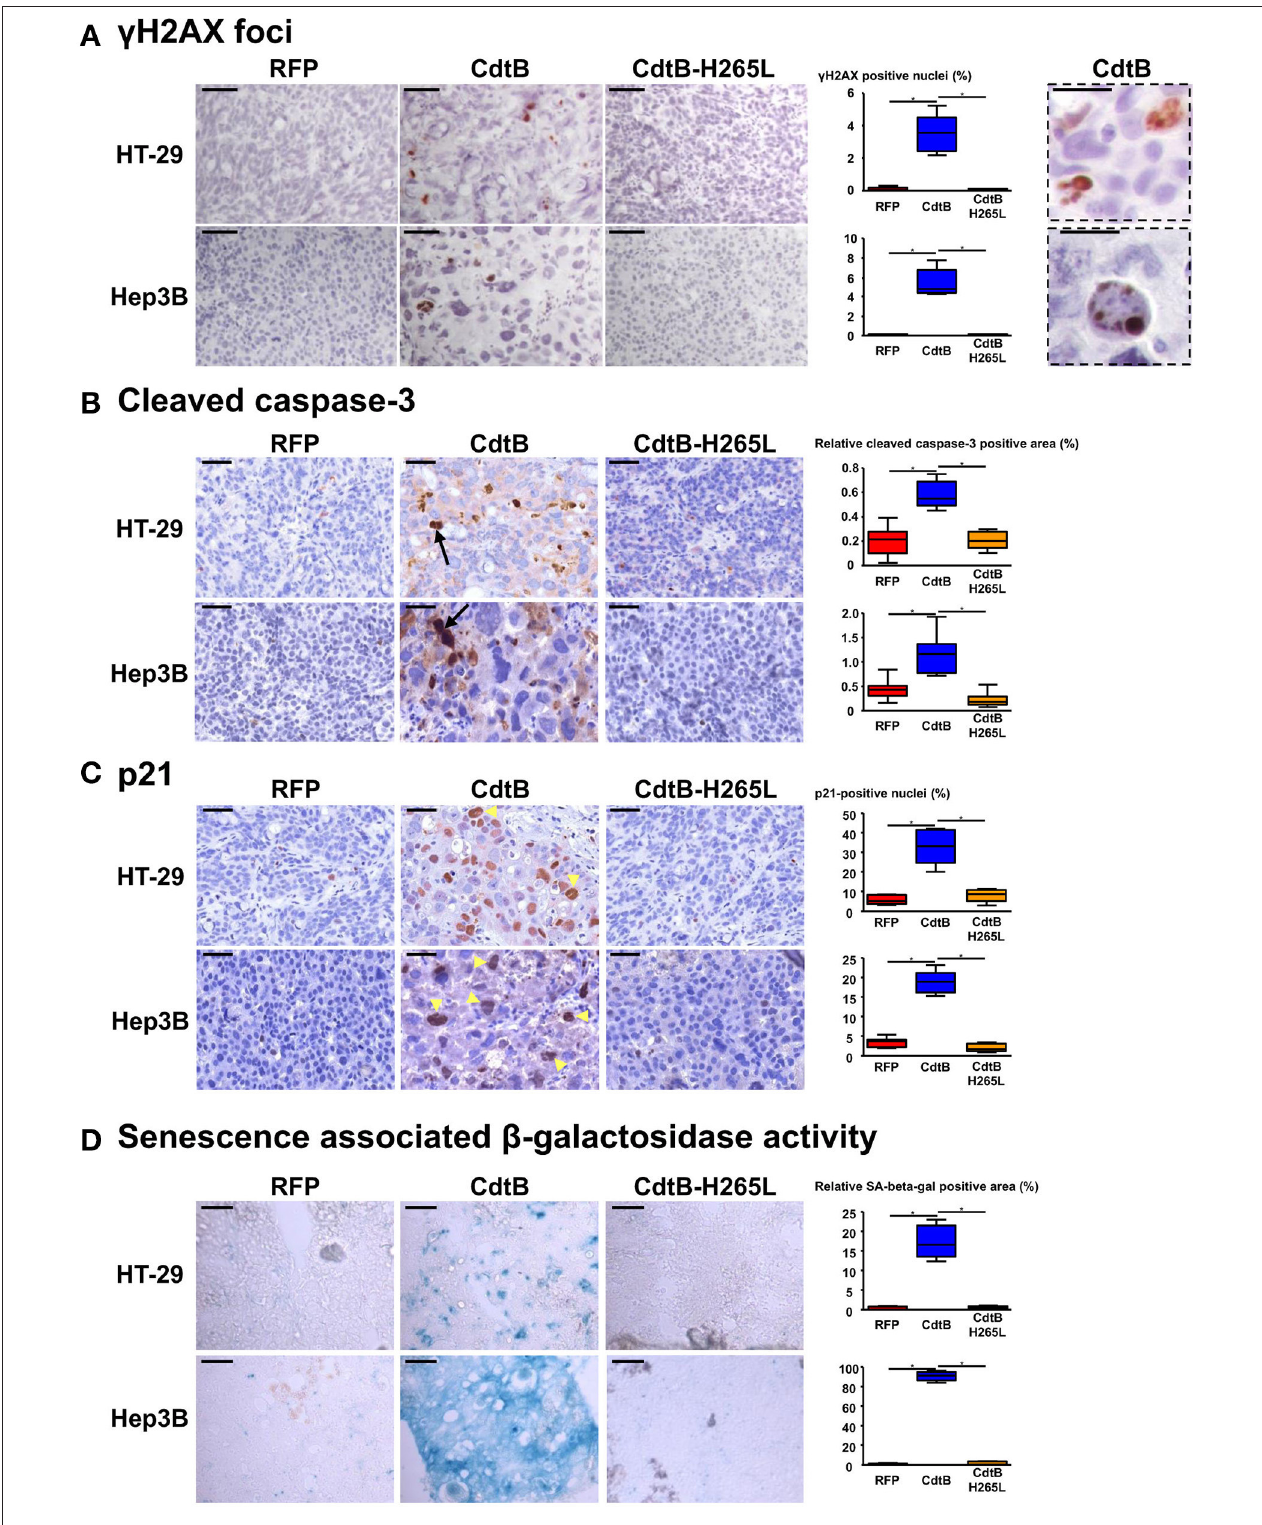
FIGURE 4 | Effect of Helicobacter hepaticus CdtB expression in tumor xenografts. Three µ m-tissue sections of HT-29- and Hep3B-derived tumors were prepared from formalin-fixed paraffin-embedded tissues and submitted to standard hematoxylin staining and immunostaining raised against γ -H2AX foci (A) , cleaved